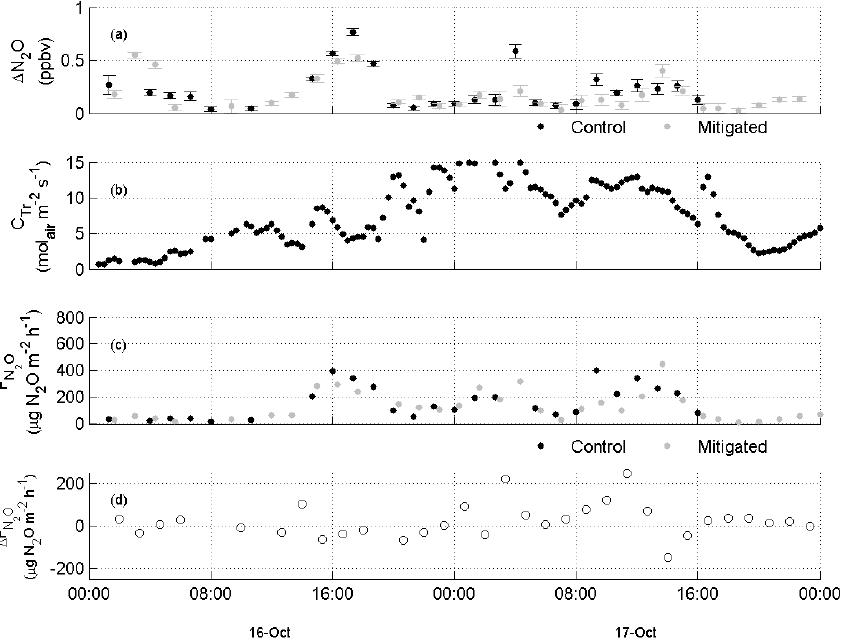
Fig. 8. (a) Time series of 1 N 2 O, (b) transfer coefficient C Tr , (c) F N mitigated treatment was a post-grazing application of 10kgha − 1 of a granular formulation of the nitrification inhibitor, dicyandiamide. values (13 mol Air m − 2 s − 1 ), while fluxes of 100 µg N 2 O– N m − 2 h − 1 can be detected at any value of C Tr